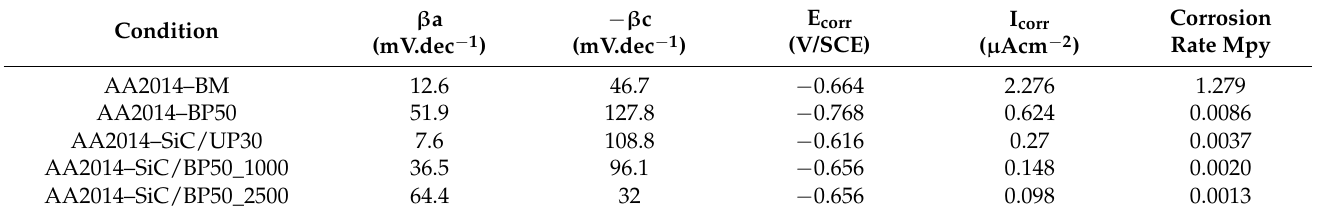
Table 3. Electrochemical parameters: corrosion potential (E corr ), corrosion current density (Icorr), and anodic ( β a) and cathodic ( β c) slopes obtained from the Tafel plots through